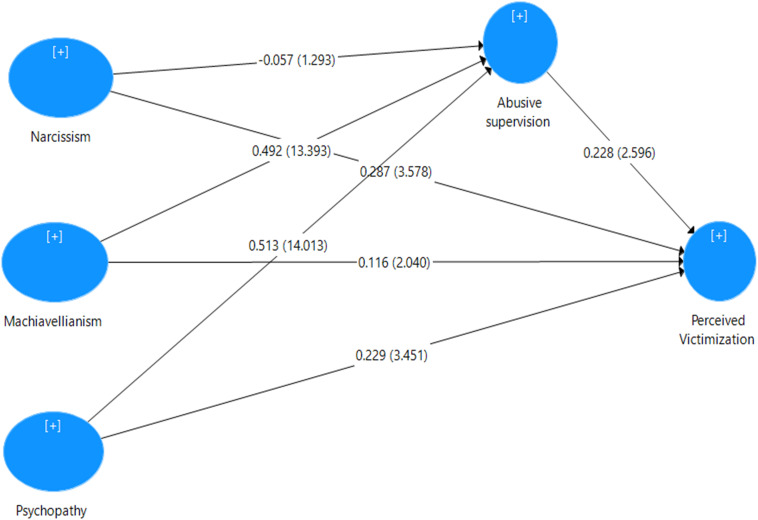
Structural model for Mediation paths.